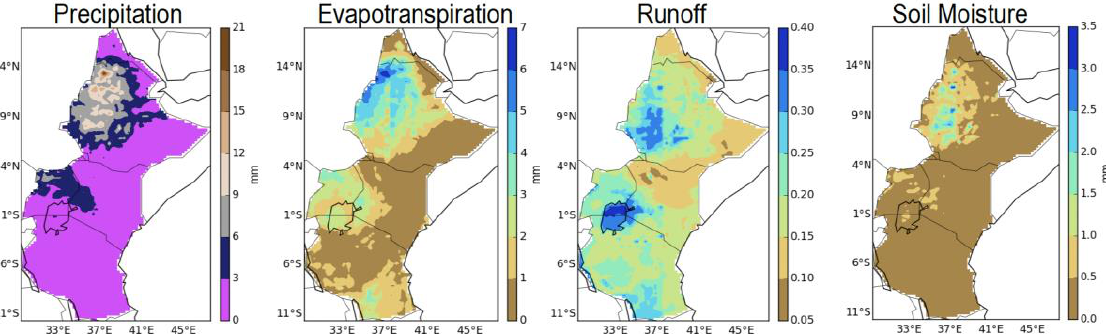
Figure 3 : Capability of RHEAS framework, example from operational system in theEast Africa region, the figure shows nowcasts of hydrologic outputs of the RHEAS